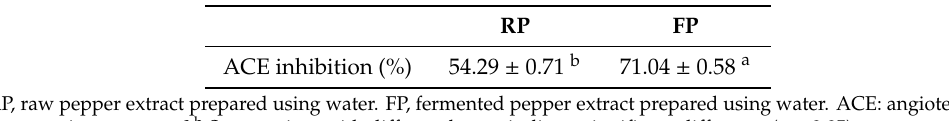
Table 3. Angiotensin I-converting enzyme (ACE) inhibition e ff ects of raw and fermented water-prepared pepper extracts.